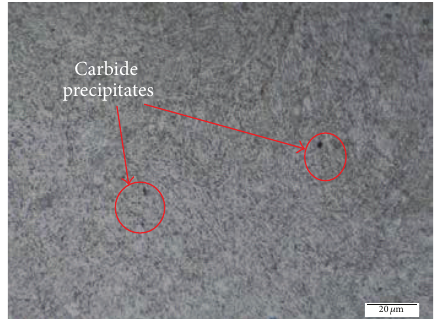
Figure 1: Microstructure of quenched and tempered AISI 4330 steel electrode, magnification